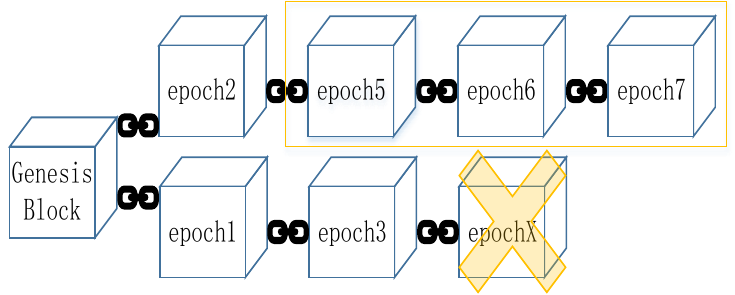
Figure 5. Example of Streamlet consensus protocol.